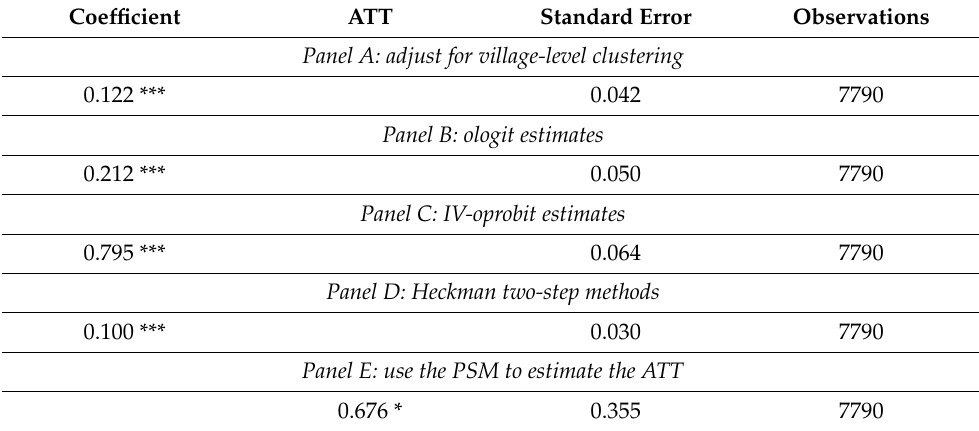
Table 4. Robustness checks: alternative